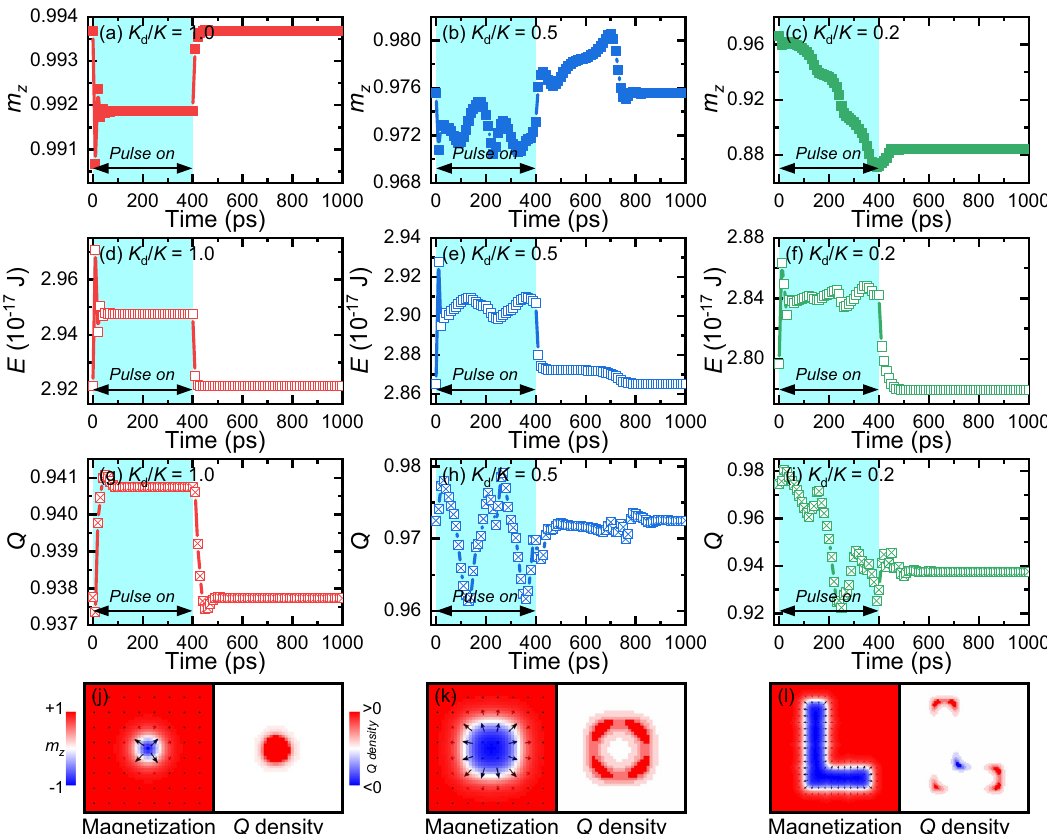
Fig. 3 Out-of-plane magnetization, energy, and topological charge of the current-driven square-shaped skyrmion. a Time-dependent out-of-plane magnetization m z corresponding to the current-induced motion of an ordinary round-shaped skyrmion in a sample with K d / K = 1. K and K d stand for the perpendicular magnetic anisotropy constants for the unmodi fi ed areas and defect lines, respectively. A 400-ps-long current pulse of j = 100 MA cm − 2 and p ¼ þ ^ x is applied, and then the system is relaxed for 600 ps. b Time-dependent m z corresponding to the current-induced hopping motion of a square- shaped skyrmion in a sample with defect lines of K d / K = 0.5. c Time-dependent m z corresponding to the current-induced deformation of a square-shaped skyrmion in a sample with defect lines of K d / K = 0.2. d Time-dependent total energy E of the system corresponding to ( a ). e Time-dependent E corresponding to ( b ). f Time-dependent E corresponding to ( c ). g Time-dependent numerical topological charge Q of the system corresponding to ( a ). h Time-dependent numerical Q corresponding to ( b ). i Time-dependent numerical Q corresponding to ( c ). j Q density distribution of an ordinary skyrmion. k Q density distribution of a square-shaped skyrmion. l Q density distribution of an L-shaped skyrmion at the fi nal